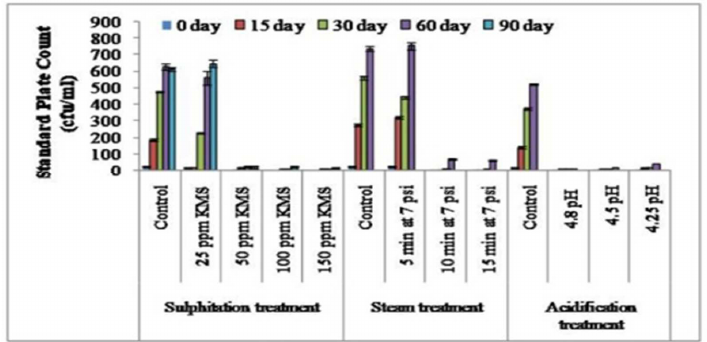
Figure 1. Effect of sulphitation, steam treatment, and acidification on standard plate count during the storage of sugarcane juice at refrigerator temperature.